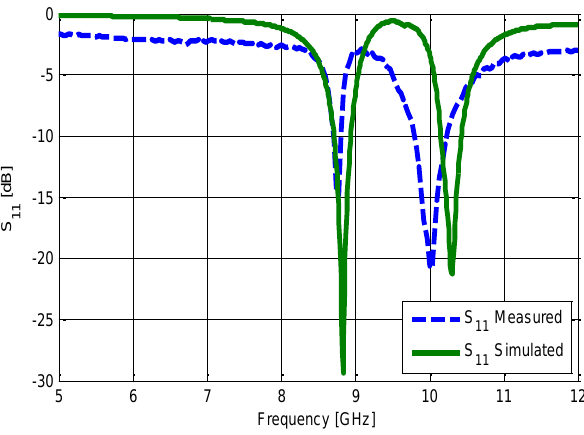
Figure 10: Measured and simulated S 11 of the proposed antenna. Table 1: Performance comparison between designed